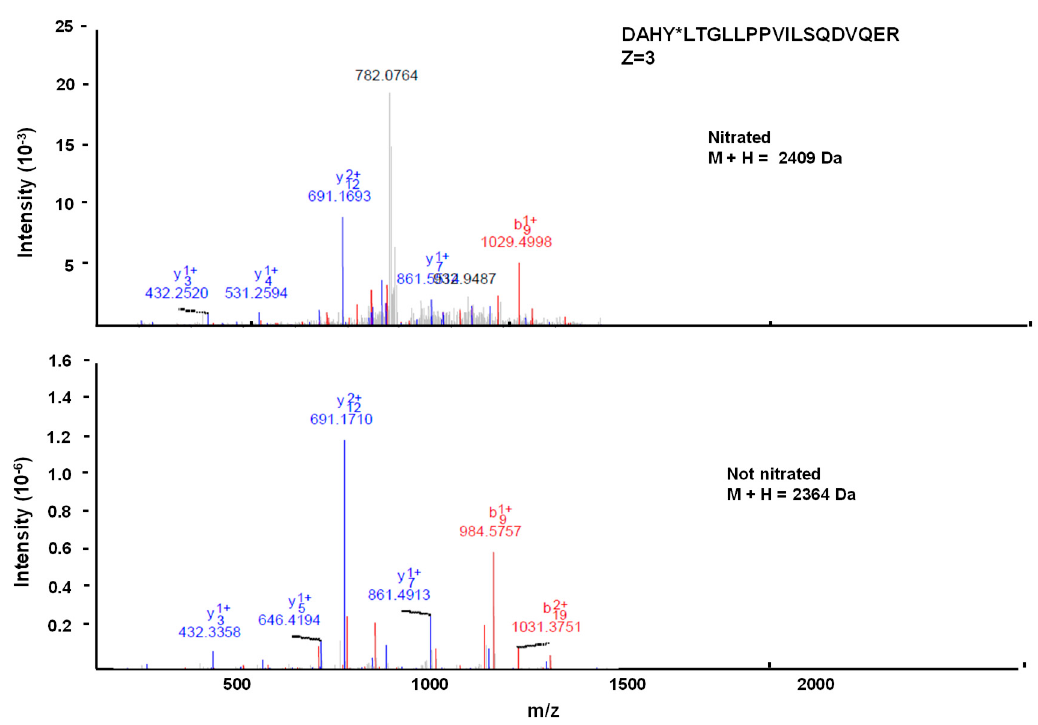
Figure 5. Comparison of the nitrated (top) and unmodified (bottom) MS / MS spectra of the identified peptide (DAHY*LTGLLPPVILSQDVQER) from Arabidopsis thaliana NADP-ME2. Peptide fragment ions are indicated by “b” if the charge is retained on the N -terminus (red) and by “y” if the charge is maintained on the C -terminus (blue). The subscript indicates the number of amino acid residues in the considered fragment from either N -terminus or C -terminus. The superscript indicates the charge (1 + or 2 + ) to the backbone fragmentation.